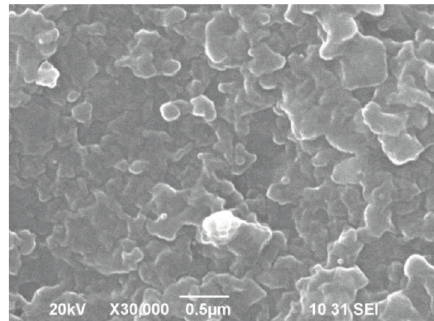
Figure 4: V 2 O 5 SEM image of at room temperature.